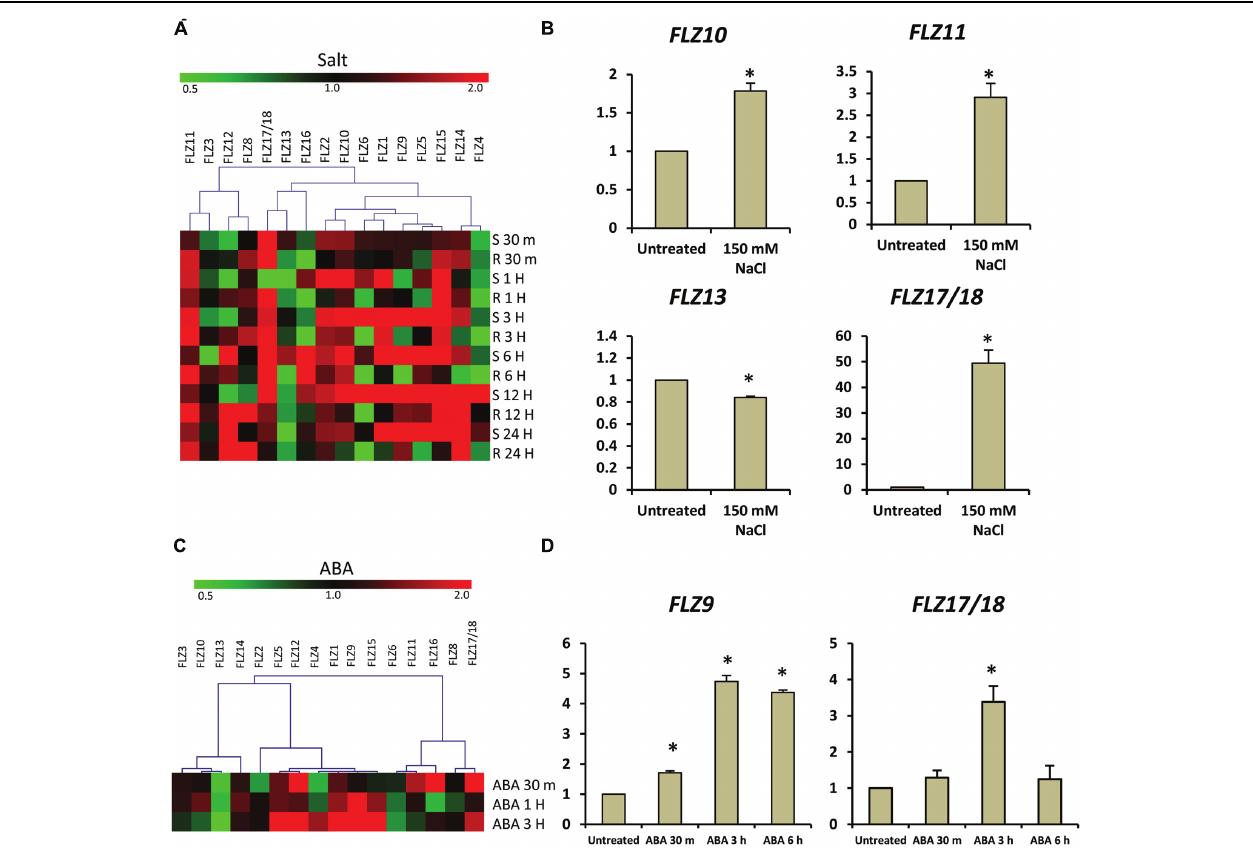
FIGURE 5 | Expression of FLZ genes during salt stress and abscisic acid. The impact of salt stress and ABA on the expression of FLZ genes was studied using available microarray data and by qRT-PCR. (A) The expression of FLZ genes during salt stress from available microarray data. The expression data was downloaded from the AtGenExpress global stress expression data set (Kilian et al., 2007) available through Arabidopsis eFP Browser (Winter et al., 2007). The genes were subjected to hierarchical clustering based on their response toward salt stress. S denotes ‘shoot’ and R denotes ‘root.’ (B) The expression of selected FLZ genes in 5-days old seedlings under salt stress. (C) The response of FLZ genes toward ABA from available microarray data available through Arabidopsis eFP Browser (Winter et al., 2007; Goda et al., 2008). (D) The expression of two selected FLZ genes in 5-days old seedlings treated with ABA at three different time points. In both salt stress and ABA treatments, the expression in 5-days old Col seedlings grown on 0.5X MS was used as the control to compare the transcript level of FLZ genes under salt stress and ABA. 18S rRNA was used as endogenous control. The bars represent the average of two independent biological experiments with three technical replicates each and error bars represent SE. Asterisk indicates a significant difference of expression in the treatment compared to control ( P < 0.005, Student’s t